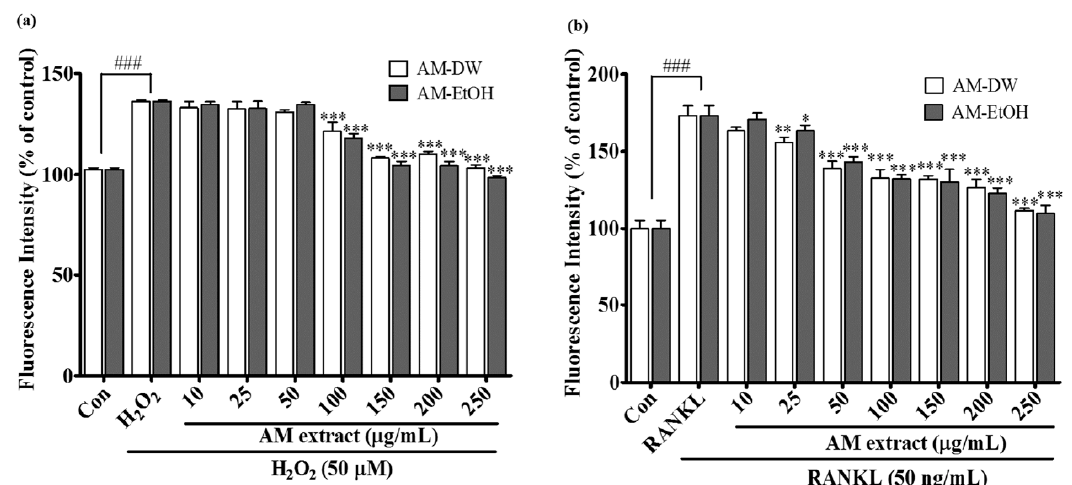
Figure 3. Effects of AM extracts on ROS inhibition. ( a ) Inhibition of H 2 O 2 induced ROS generation in RAW 264.7 cells by AM extracts; ( b ) Inhibition of RANKL induced ROS generation in RAW 264.7 cells by AM extracts. After 24 h of sample treatment 10 μ M of H 2 DCF-DA was added to the cell and incubated for 40 min, following addition of 50 μ M H 2 O 2 or, 50 ng/mL RANKL for 1 h. All data are presented as the mean ± SD of three independent experiments performed with n = 3. Compared positive control (not treated group) vs. negative control (only H 2 O 2 or RANKL treated group ### p < 0.001) and negative control vs. sample treated group (* p < 0.05, ** p < 0.01, *** p < 0.001).